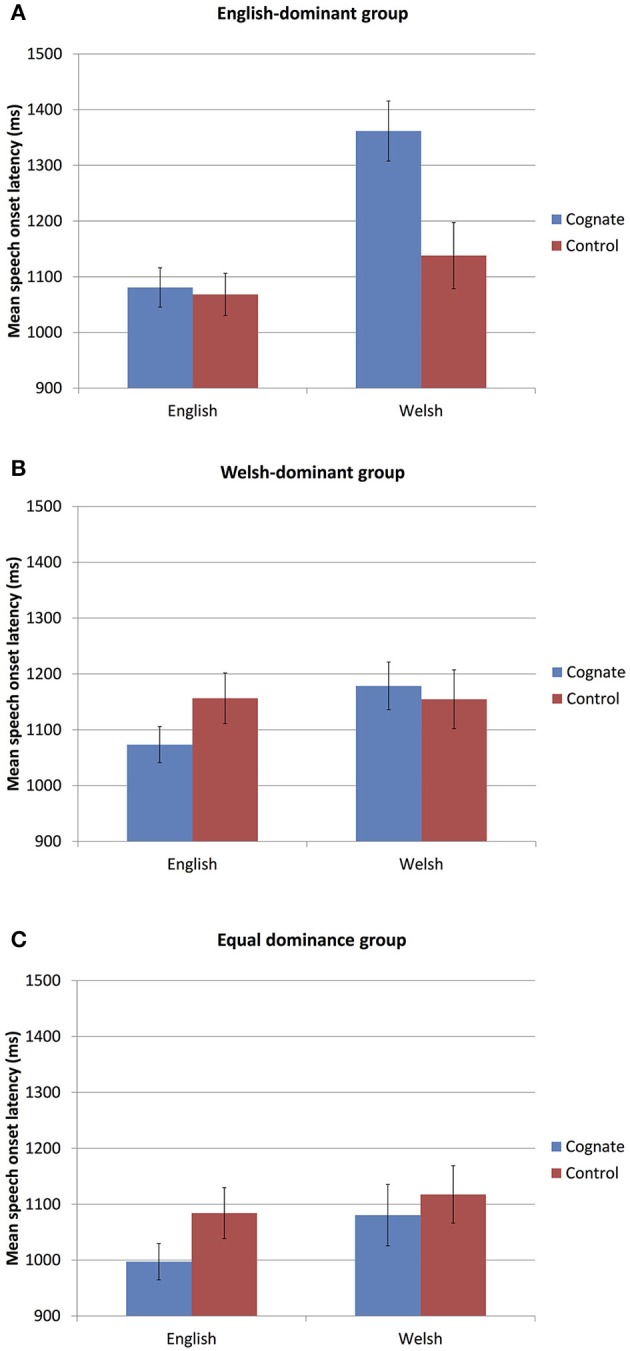
(A–C) Mean naming latencies for Cognates and Controls in each Language Dominance group (A, English-dominant; B, Welsh-dominant; C, equal dominance) and in each Target Language. Error bars represent the standard error of the mean across participants and are for illustrative purposes only.